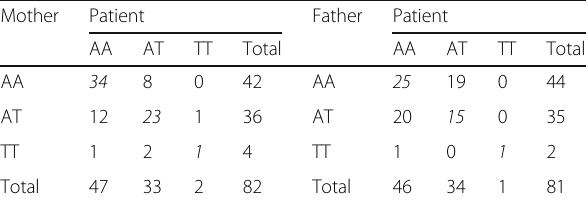
Table 2 Concordance of INS -23/Hph1 A>T polymorphisms between type 1 diabetic children and their parents